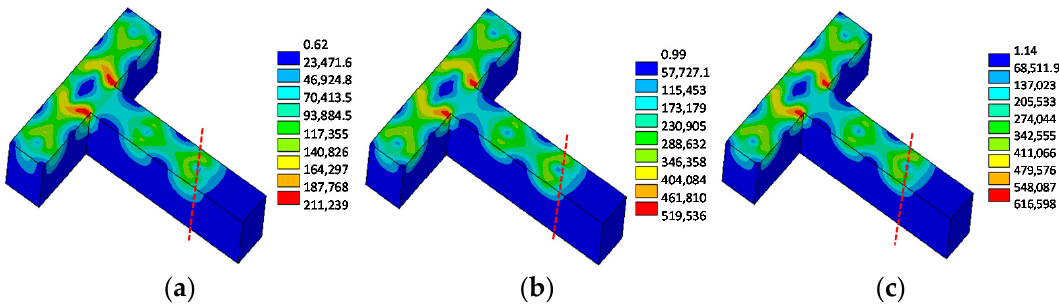
Figure 7. Distribution of Lorentz force: ( a ) 100 A, ( b ) 150 A, ( c ) 200 A (unit: N/m 3 ).